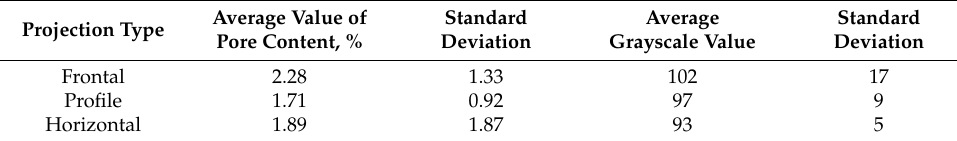
Table 1. Porosity and mean grayscale value for X-ray CT projections. Projection Type